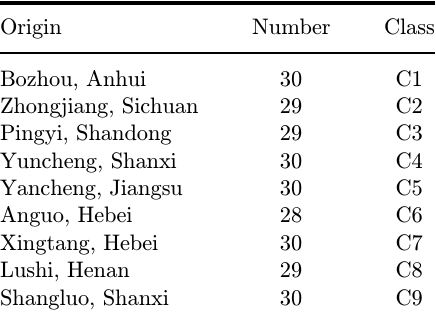
Table 1. Class, origin and number of the 265 salviae miltiorrhizae radix